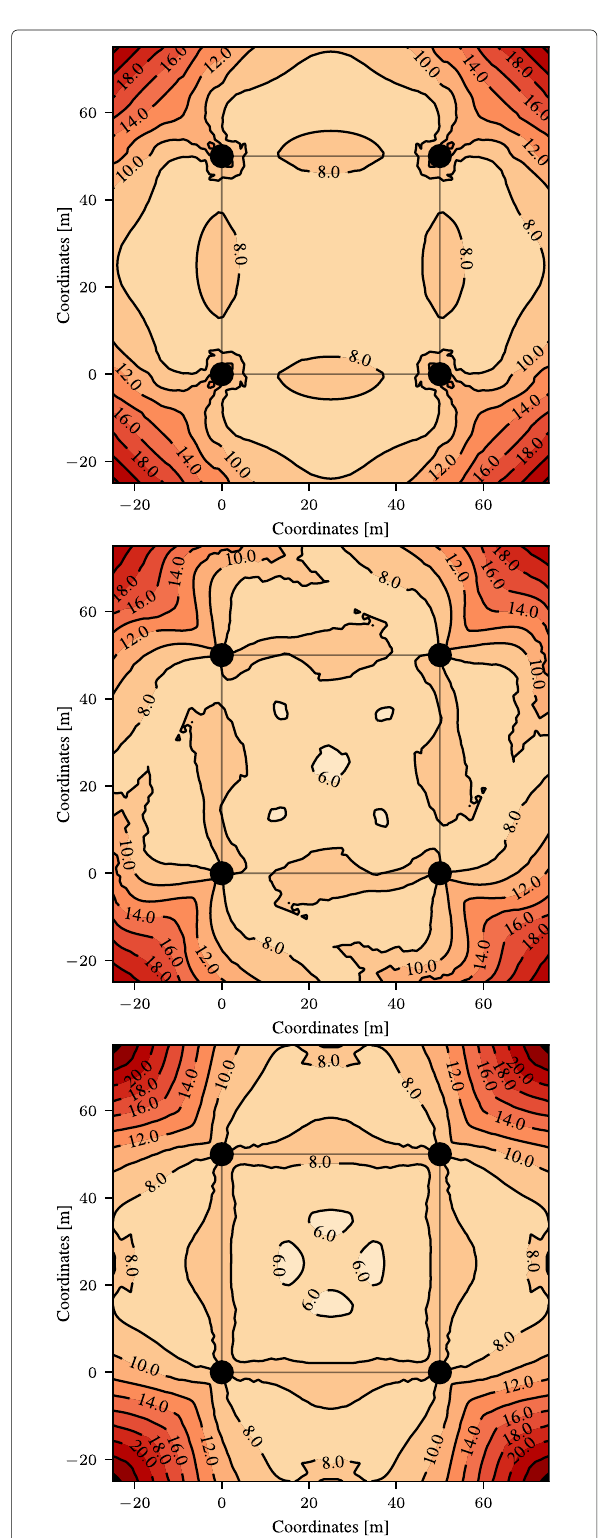
Fig. 8 Position RMSE for different rotation of sensor nodes. a Rotation: 0°. b Rotation: 30°. c Rotation: 45